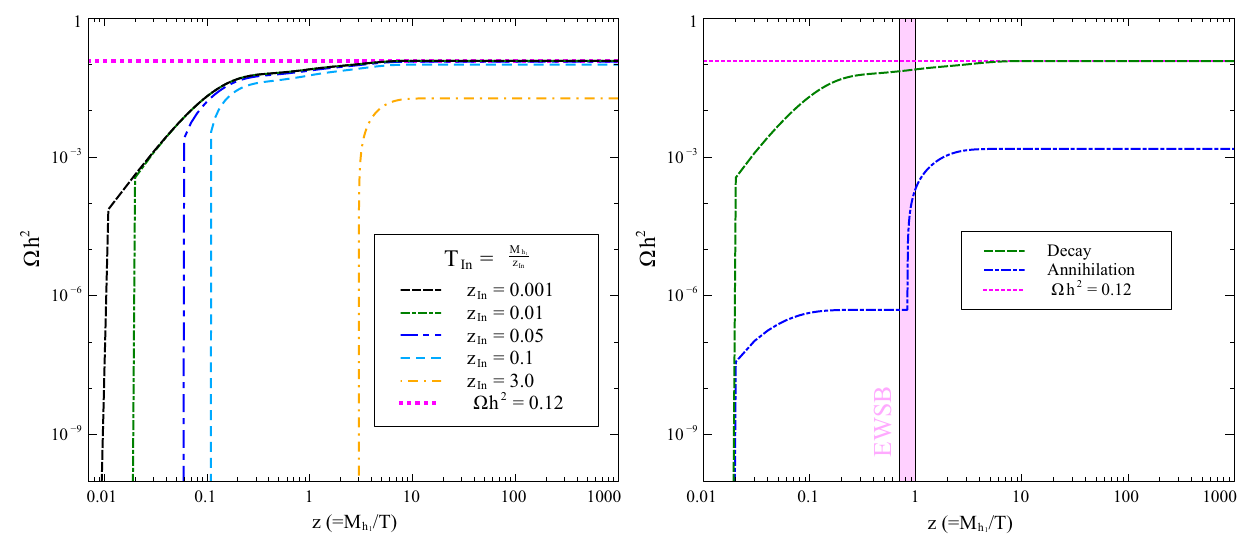
Fig. 8 Left (right) panel: Variation of relic density (cid:9) h 2 with z for dif- ferent initial temperature (contributions to (cid:9) h 2 coming from decay and annihilation), where the other parameters are fixed at λ Dh =